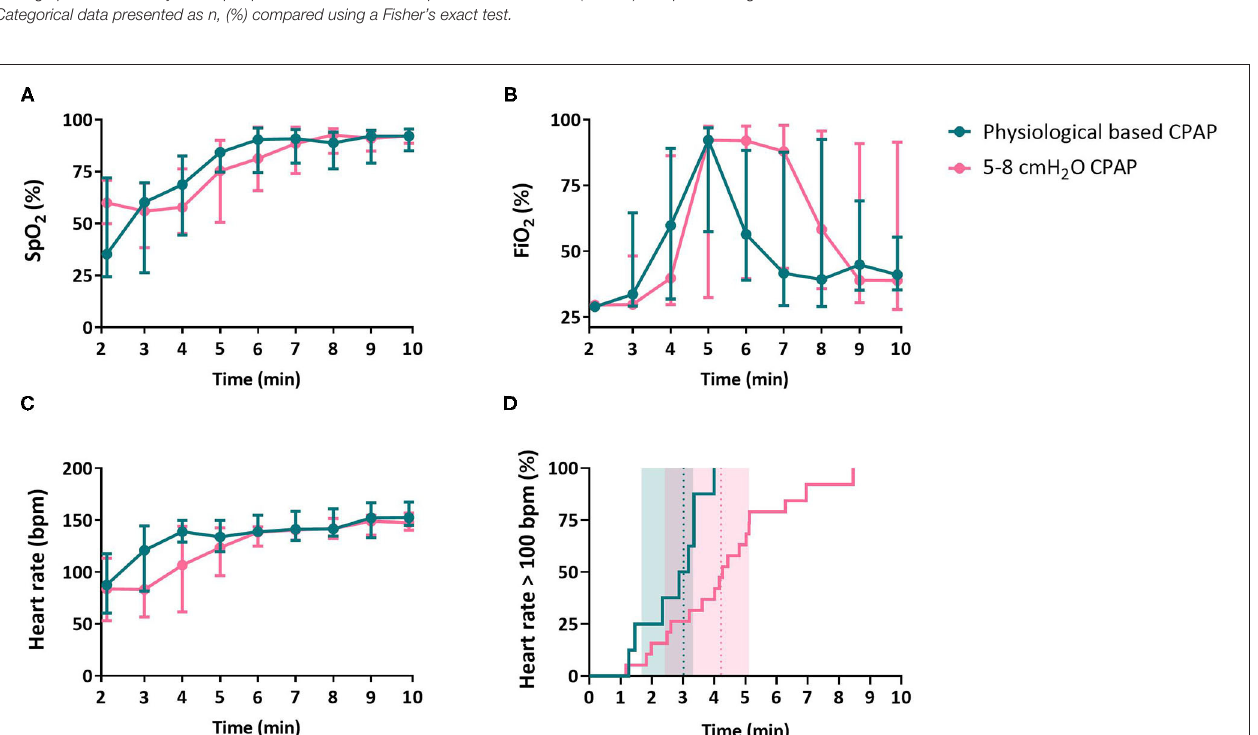
Frontiers in Pediatrics |